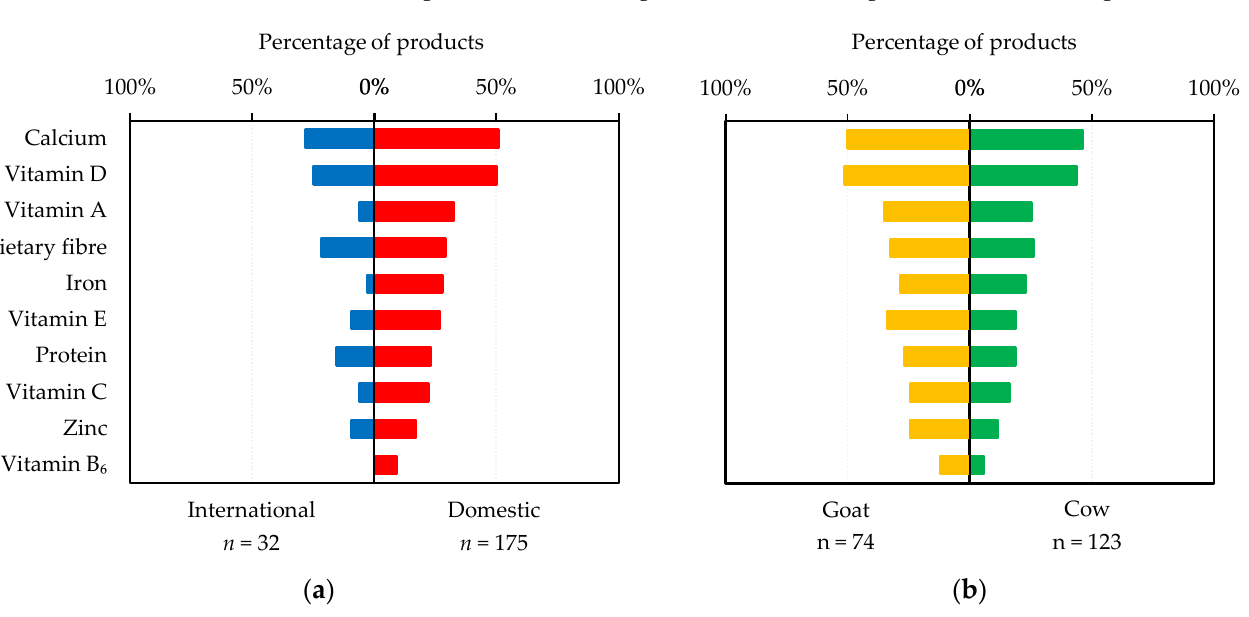
Figure 4. Percentage of milks targeting Chinese older adults made nutrition claims on specific nu- trients that appeared on at least 5% of all products: ( a ) international brand vs. domestic brand; ( b ) goat milk vs. cow milk.